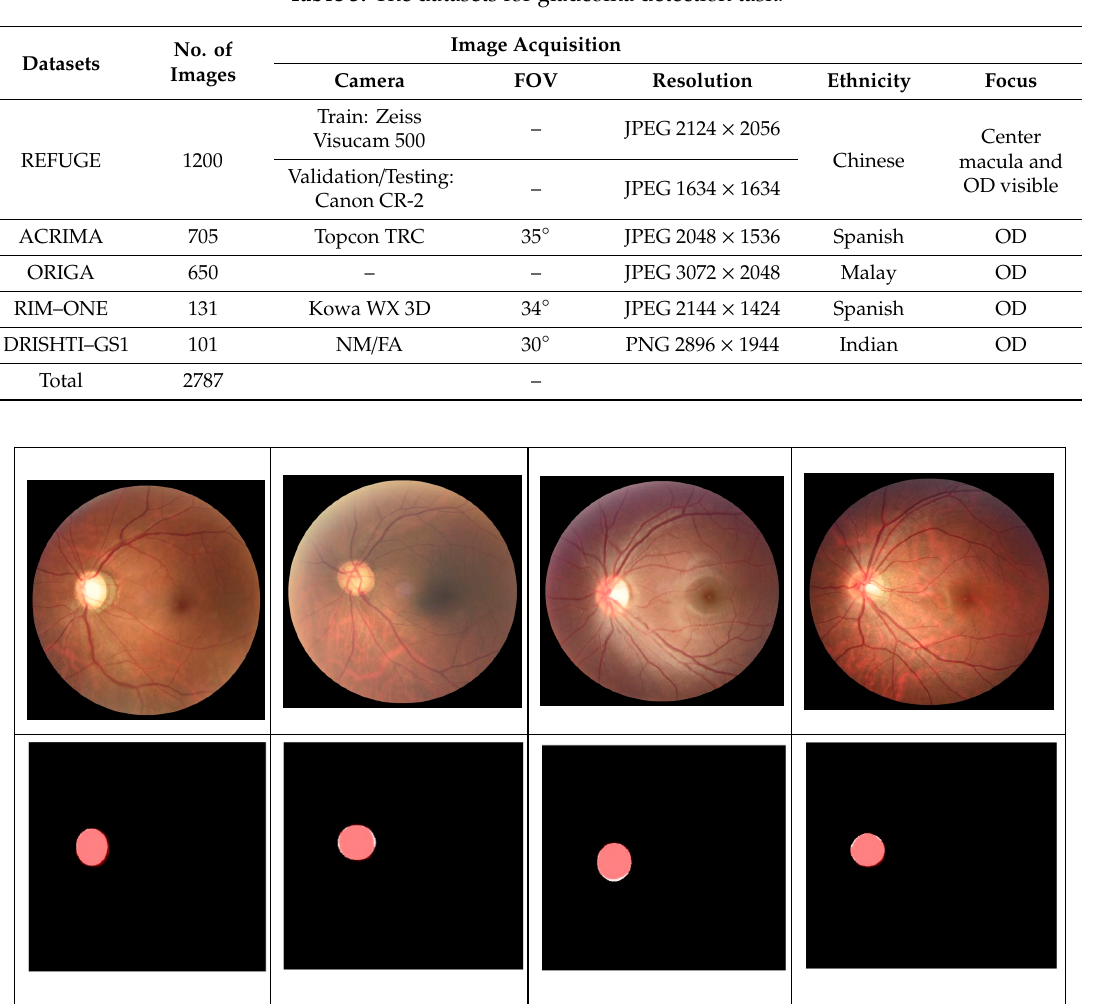
Table 3. The datasets for glaucoma detection task.